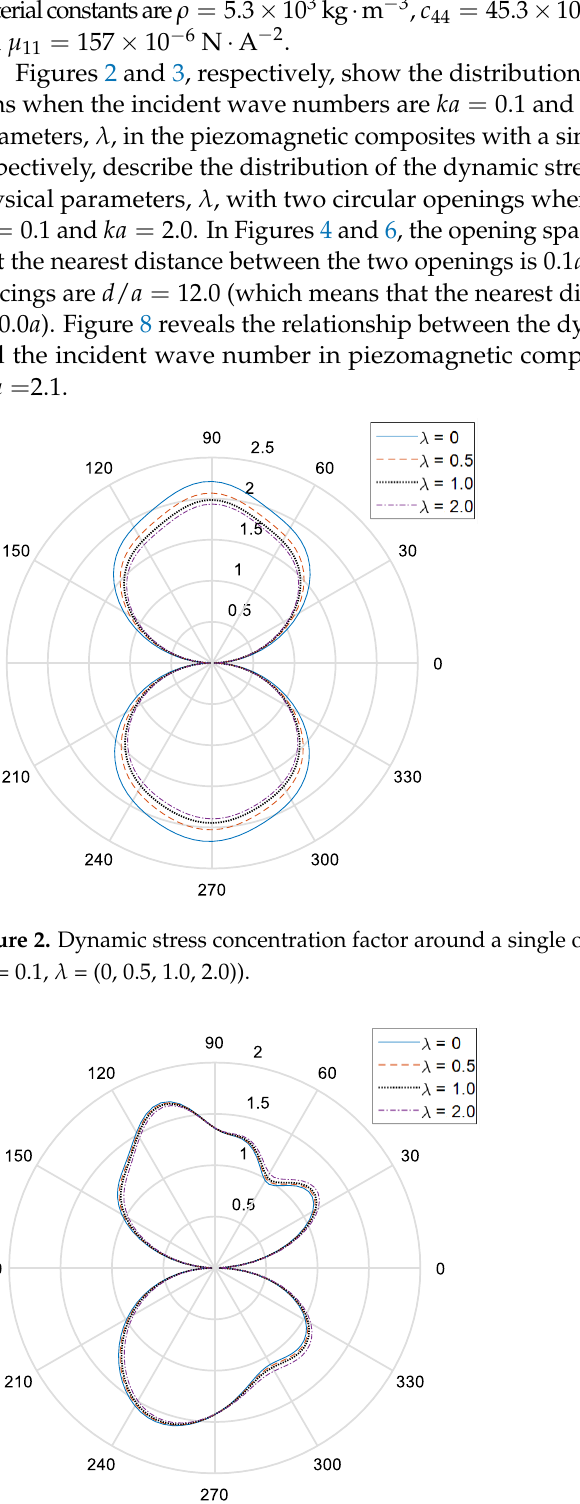
Figure 3. Dynamic stress concentration factor of single opening under different piezomagnetic con- stants ( ka 2.0, (0, 0.5, 1.0, 2.0]).